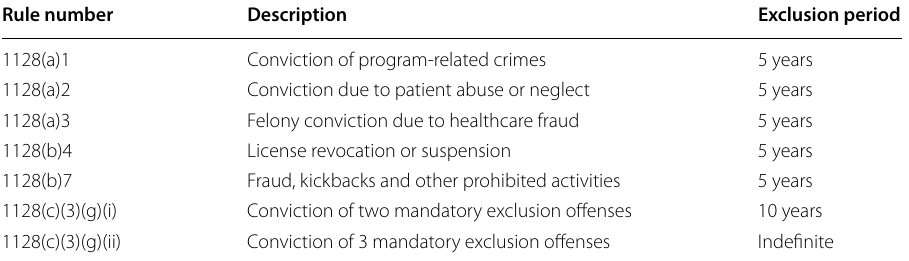
Table 1 Selected LEIE rules